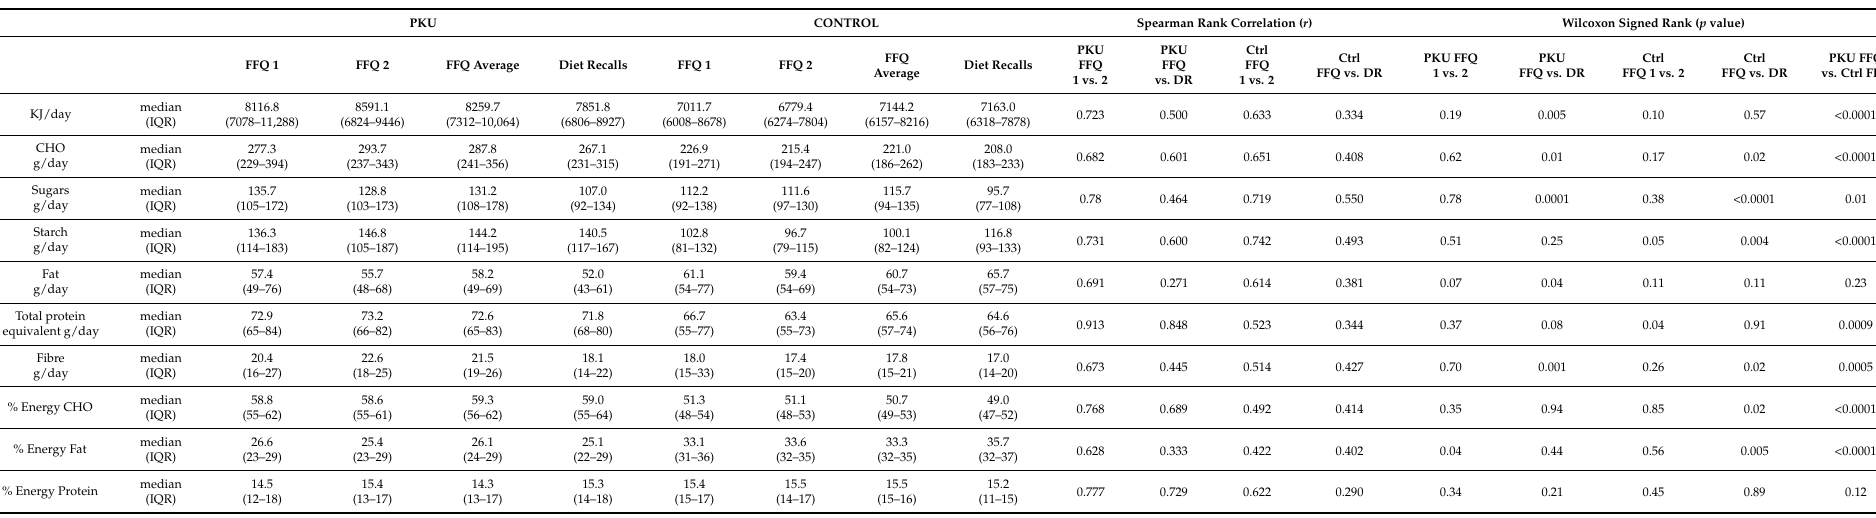
Table 3. Nutrients—median (IQR) intakes FFQ 1 vs. FFQ 2 and FFQ vs. Dietary Recalls (DR) for PKU and control groups; and FFQ PKU vs.